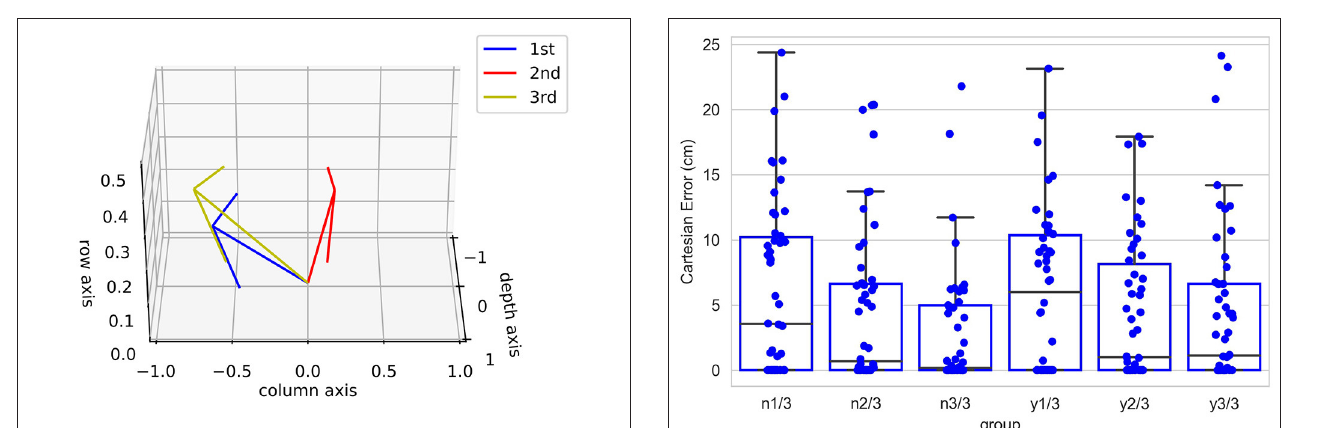
FIGURE 10 | Examples of three-dimensional motion direction. This figure shows three spatial vectors along the column axis, row axis and depth axis, correspondent to the three motion represented in Figure 7 .